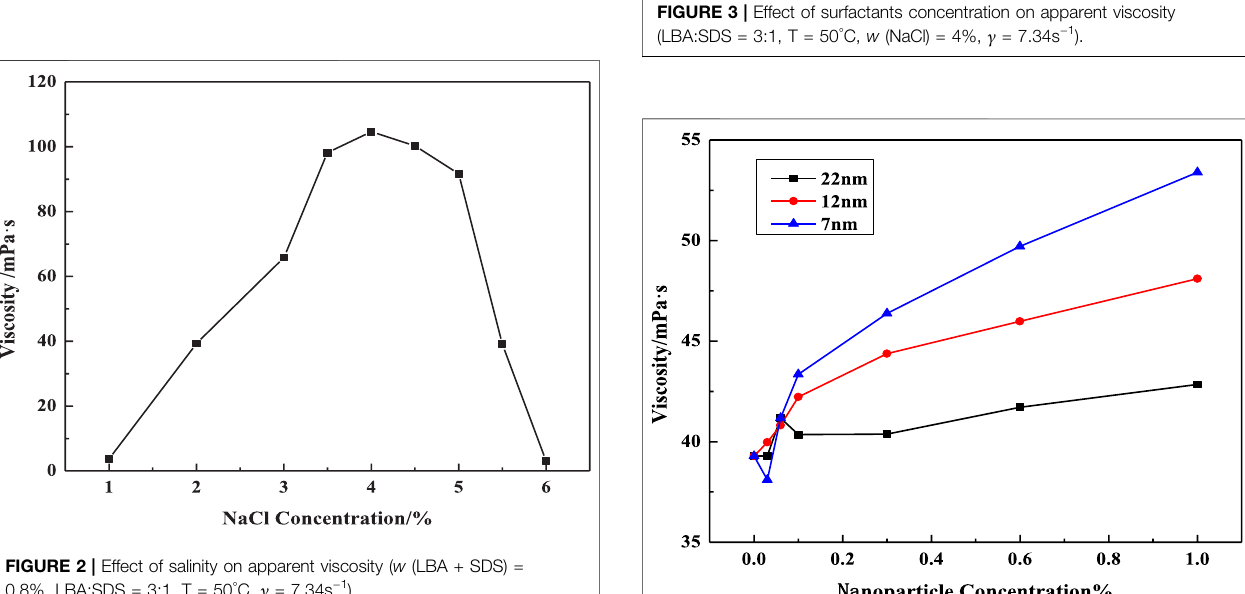
FIGURE 1 | Effect of LAB percentage on apparent viscosity ( w (LBA + SDS) (cid:2) 1%, w (NaCl) (cid:2) 1%, T (cid:2) 50 ° C, γ (cid:2) 7.34 s − 1 ).